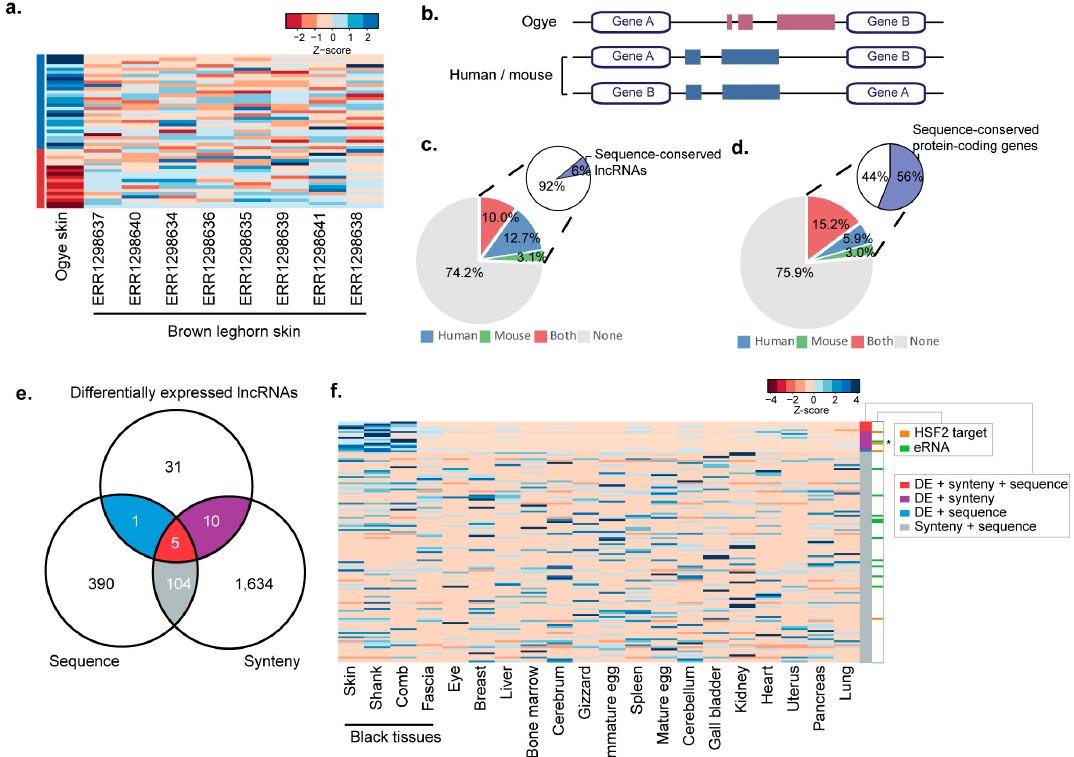
Figure 6. Black tissue-specific lncRNAs with sequence and synteny conservation. ( a ) Expression patterns of differentially expressed lncRNAs in Ogye skin compared to Brown leghorn skin samples. Expression levels are indicated with a color-coded Z-score (red for low and blue for high expression) as shown in the key. ( b ) Cartoon showing a lncRNA that is syntenically conserved with upstream and downstream protein-coding genes in the human and/or mouse genome. ( c ) The fraction of lncRNAs with syntenic conservation in the human (blue), mouse (green) or both (red) genomes is shown in the pie chart. Of the syntenically conserved lncRNAs, the fraction of lncRNAs with sequence conservation (purple) in the human or mouse genome is indicated in the secondary pie charts. ( d ) The fraction of protein-coding genes with synteny conservation is indicated in the pie chart. Otherwise, as in ( c ). ( e ) The numbers of differentially expressed lncRNAs in black skin with evidence of sequence and synteny conservation are indicated in a Venn diagram. Functional evidence for differential expression (DE) + synteny + sequence (red), DE + synteny conservation (purple), or DE + sequence conservation (blue) are indicated in the Venn diagram. ( f ) Sixteen blackskin-specific lncRNAs are shown in a heatmap with functional evidence (colors correspond to ( e )) A total of 104 non-specific lncRNAs with evidence of sequence + synteny conservation are indicated in gray. The co-regulation models associated with a certain lncRNA are indicated to the left with color codes (orange for HSF2 binding and green for eRNAs). * indicates the eRNA associated with HSF2. The expression level is indicated with a color-coded z-score, as shown in the key.